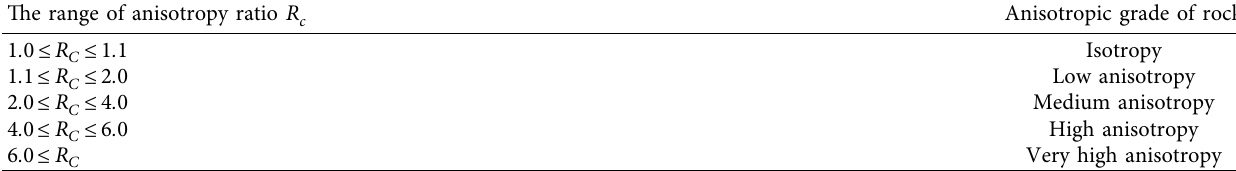
Table 2: Anisotropic classification [18].